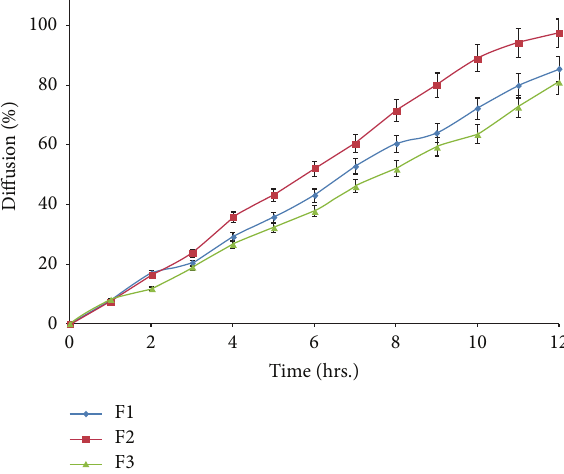
Figure 3: In vitro dissolution studies of plain HCT, marketed formulation, and developed SNEDDS, data expressed as mean ± SD ( 𝑛 = 3 ).